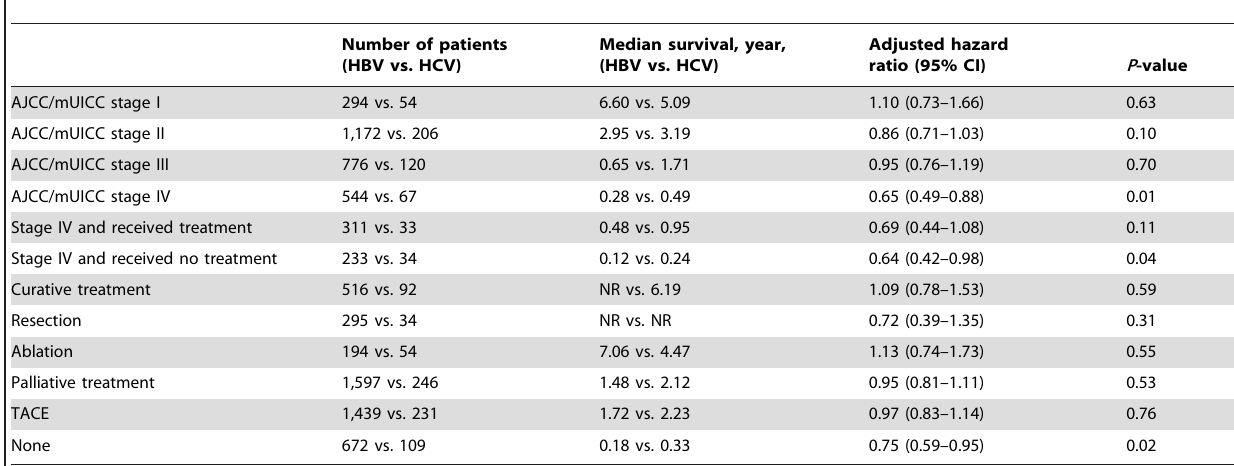
Table 4. Adjusted difference in the survival between hepatitis B virus and hepatitis C virus related hepatocellular carcinoma by subgroup.